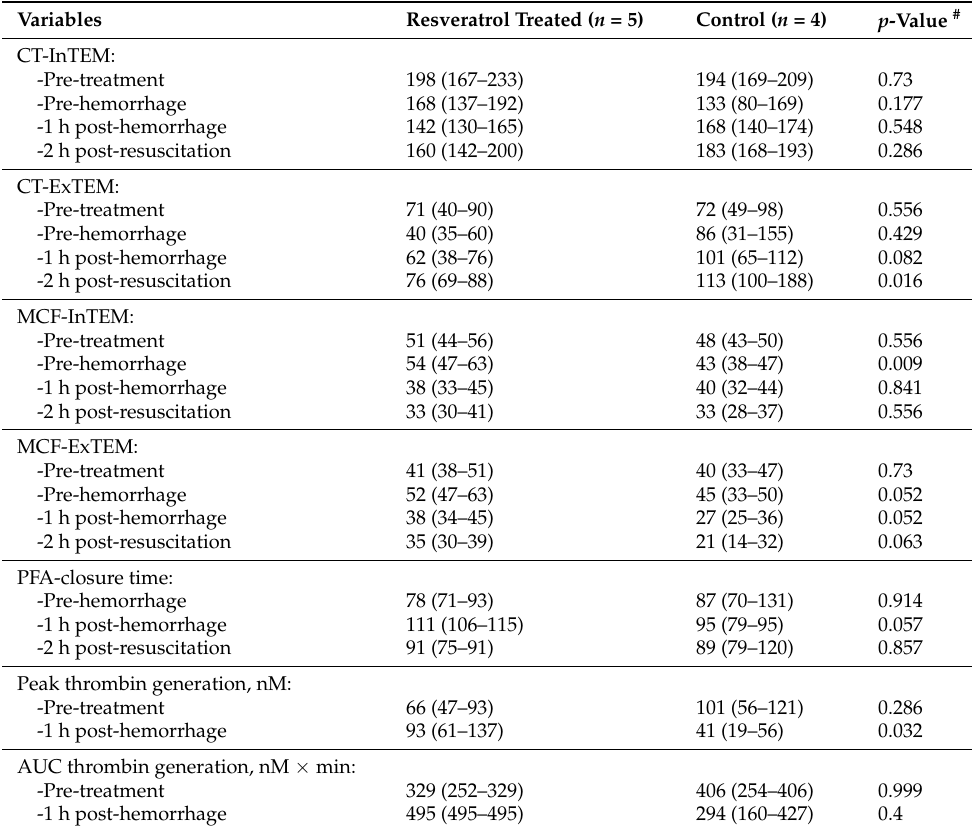
Table 3. Rotational Thromboelastometry (ROTEM ® ) viscoelastic and thrombin generation parameters of the anesthetized greyhound dogs before and after induced hemorrhage ( n =